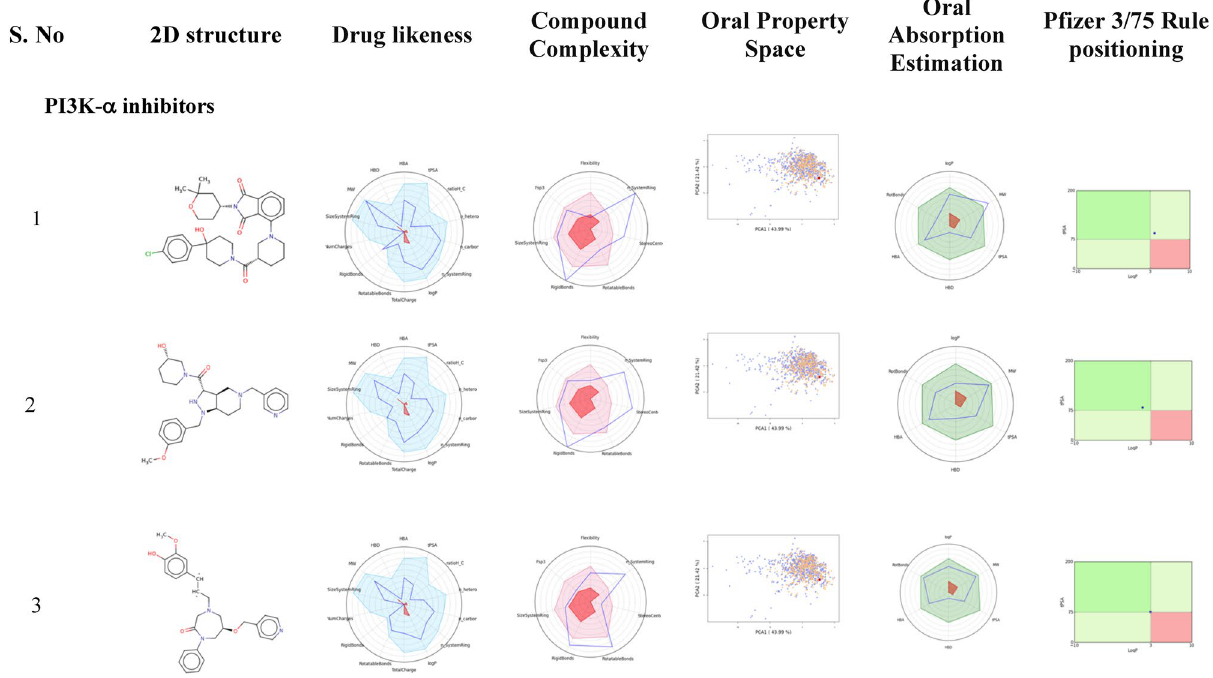
Figure 9. . 2D structure, drug-likeness, compound complexity, oral property space, oral absorption estimation, and Pfizer 3/75 rule positioning of the lead molecules of PI3K-α and PKC-η were assessed by using FAF-Drugs and Swiss-ADME